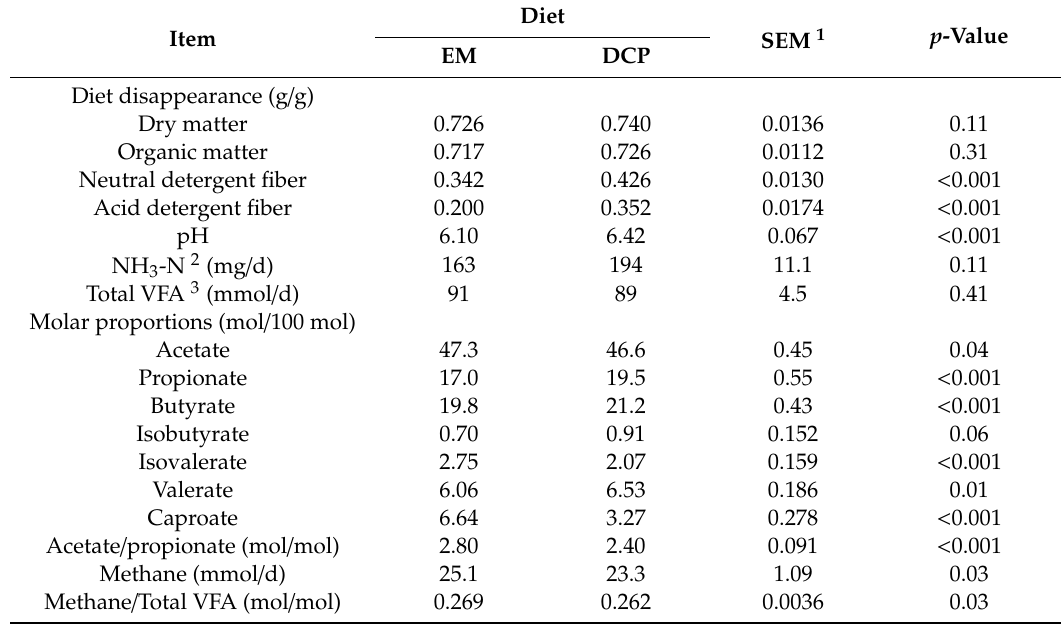
Table 3. E ff ects of replacing extruded maize (EM) by dried citrus pulp (DCP) on diet disappearance and ruminal fermentation parameters in Rusitec fermenters (n = 4).